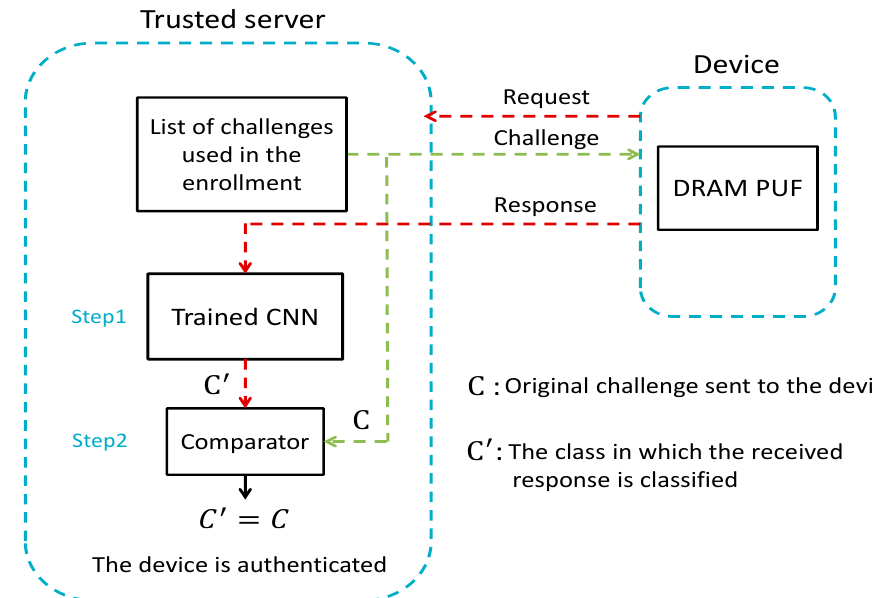
Figure 4. The authentication phase includes communication process and verification steps in the server.